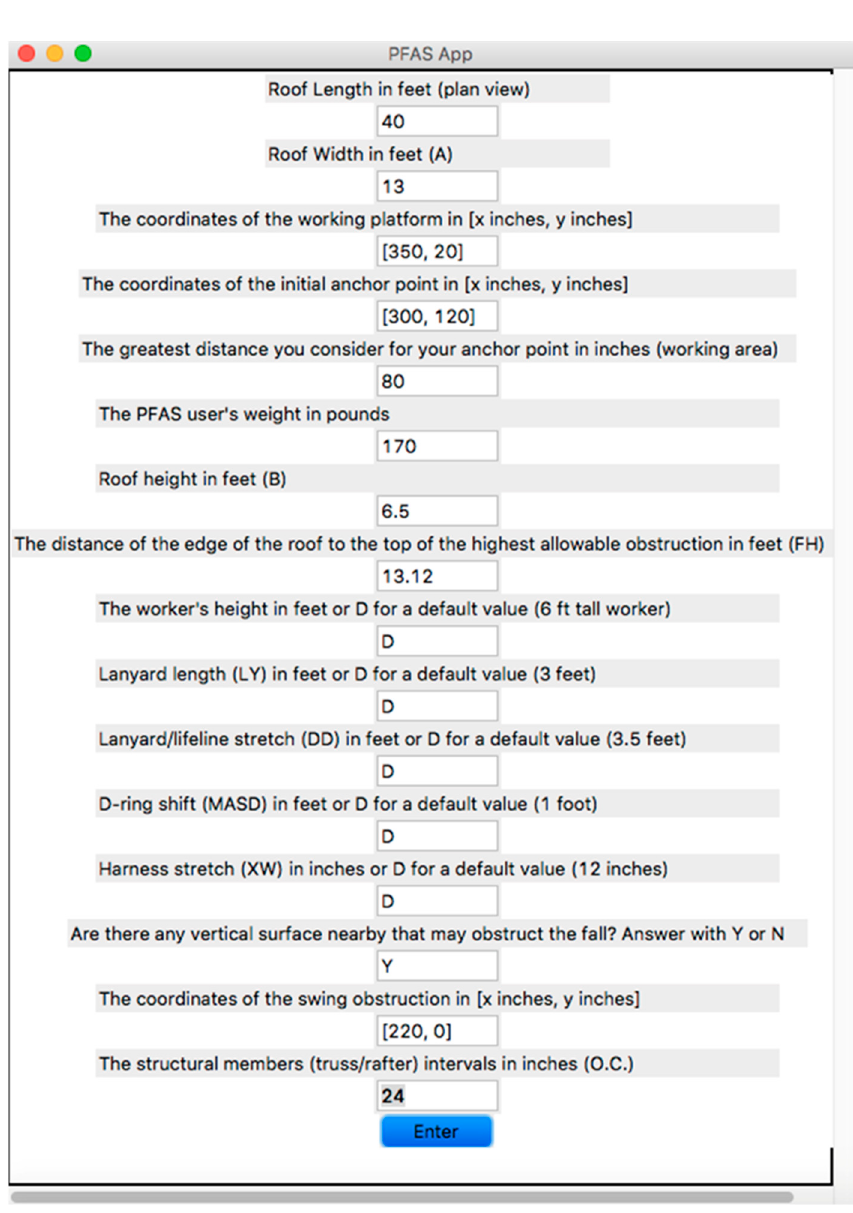
Figure 7. The user input panel with 16 input parameters (for the gable roof scenario).